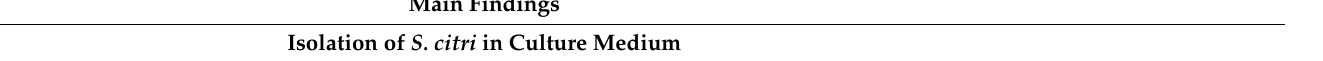
Table 4. Summary of the main findings from the different Spiroplasma citri detection tests. Tested